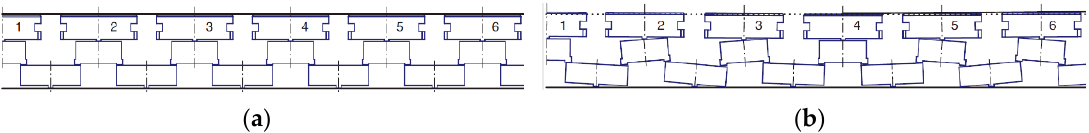
Figure 3. The principle of the lever tilting, ( a ) without the shaft deflection (misalignment); ( b ) at the shaft deflection (misalignment).